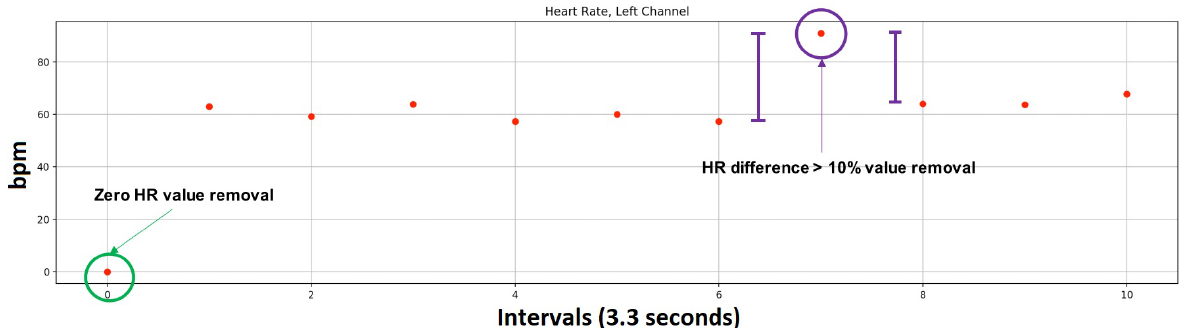
Figure 5. HR values from rPPG required noise removal by eliminating non-sense HR values from the HR-RAW data, such as zero and adjacent values with changes greater than